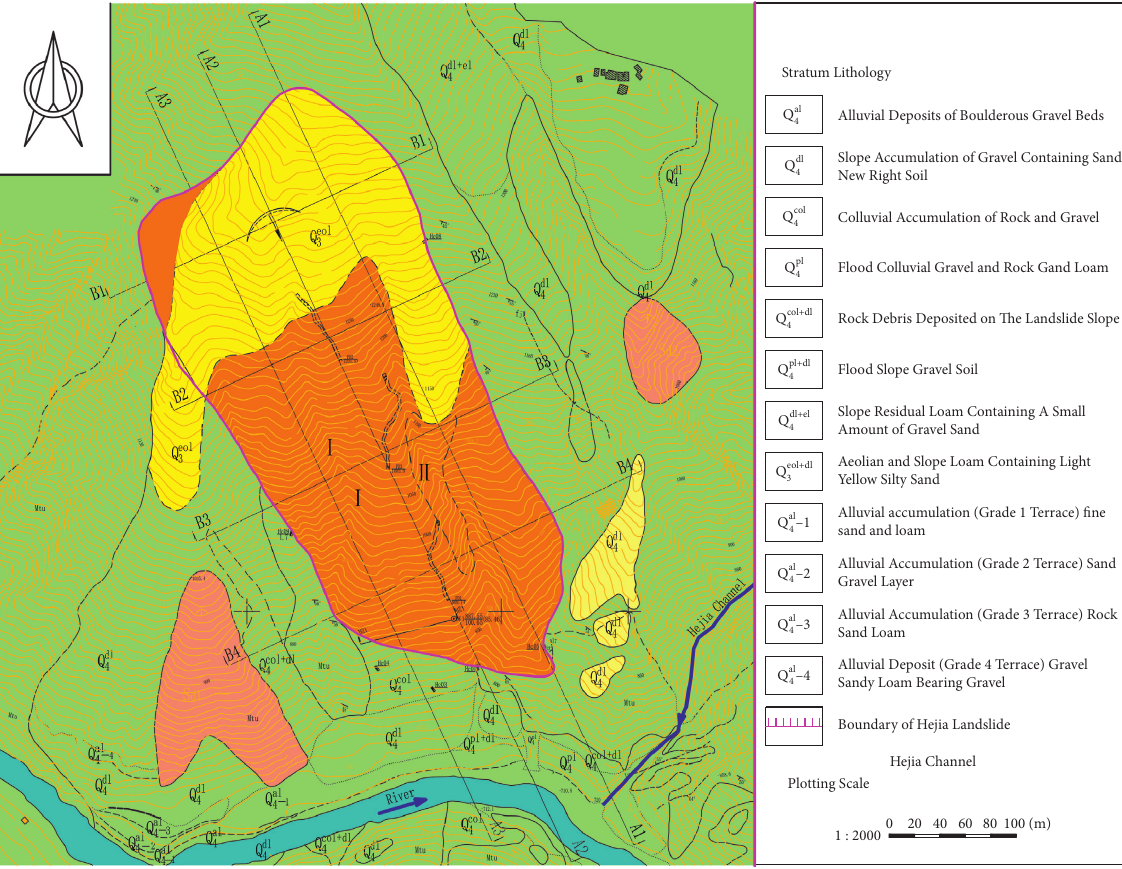
Figure 2: Geological plan of the Hejia landslide.